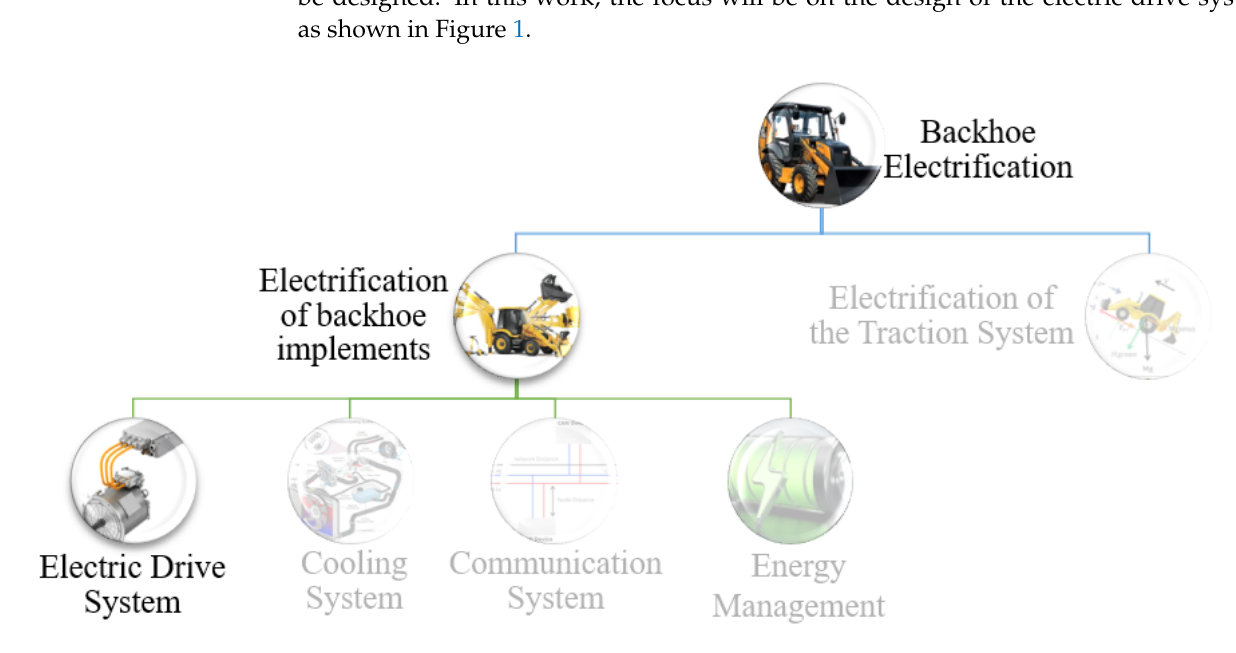
Figure 1. Scheme of the electrification project of a heavy